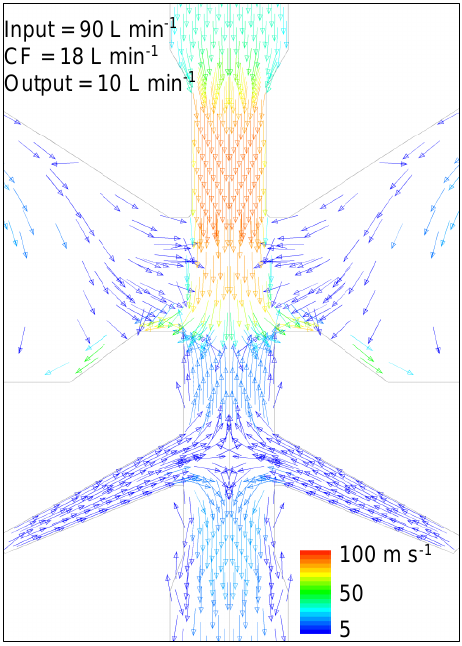
Figure 4. CFD-simulated velocity pathlines. The center region, where the downward and upward velocities meet, coincides with the location of two stagnation planes (the first one at the collector inlet and the second one at the CF outlet) and nozzle jet surface